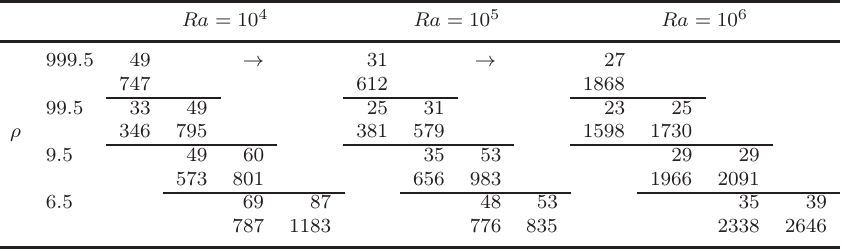
Table 3. Results of computational